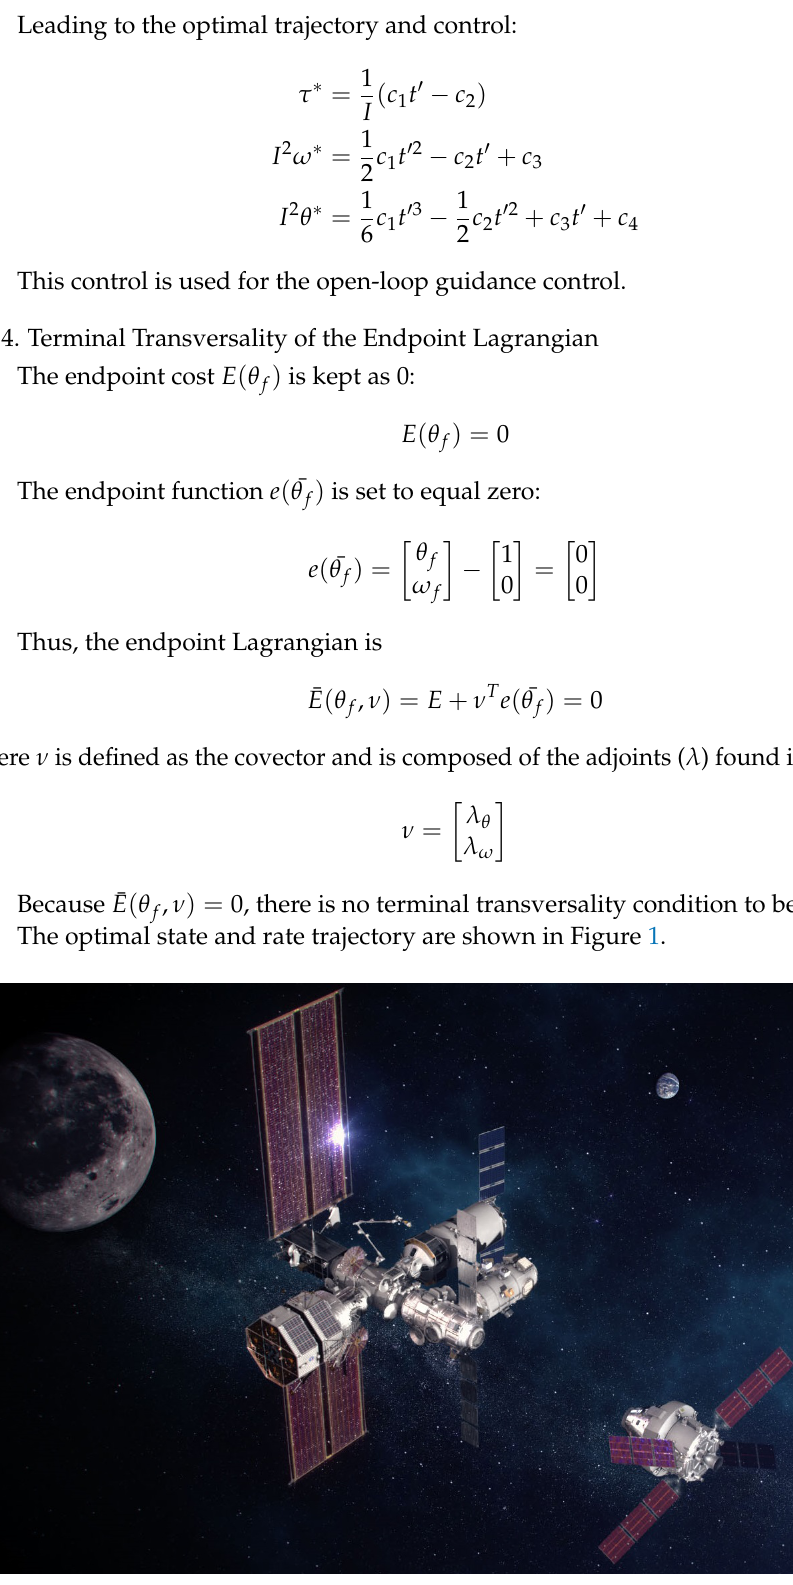
Figure 1. Artemis missions, NASA will land the first woman and first person of color on the Moon, using innovative technologies to explore more of the lunar surface than ever before image courtesy NASA [27], image use in accordance with NASA image use policy: